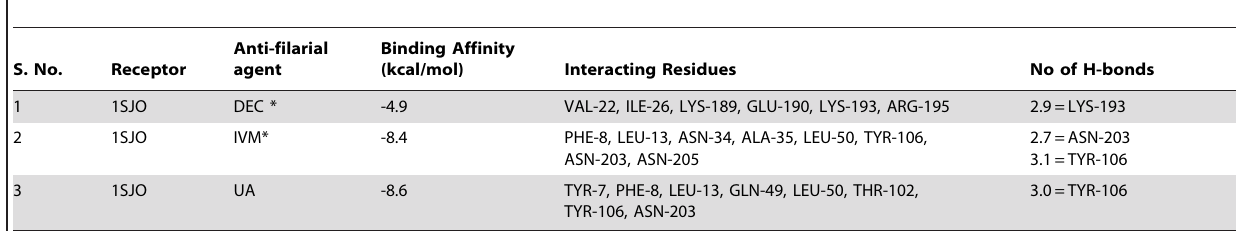
Table 2. Details of Docking energy, active site pocket residues and H-bonds revealed by molecular docking of DEC, IVM and UA on Bm GST of B. malayi .